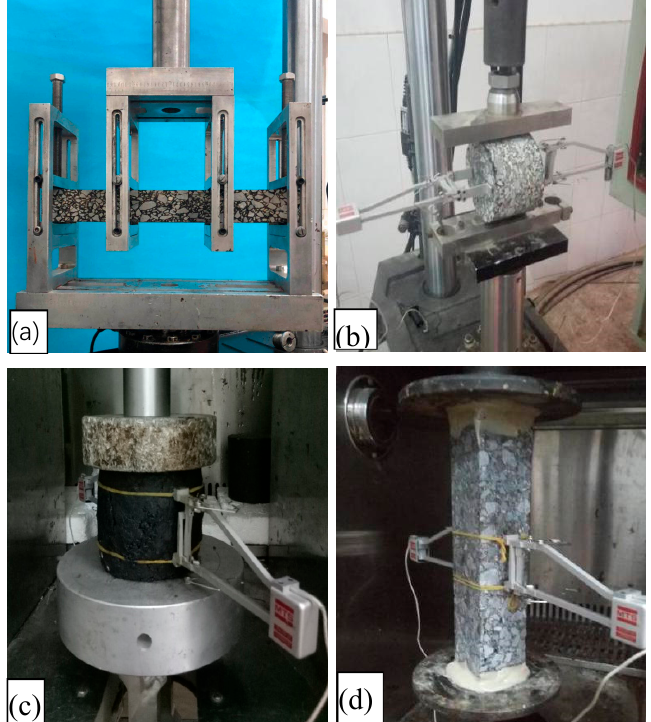
Figure 3. Photographs of the test equipment: ( a ) four-point bending test, ( b ) indirect tensile test, ( c ) unconfined compressive test, ( d ) direct tensile test. Table 4. Loading cycles at different loading frequencies.